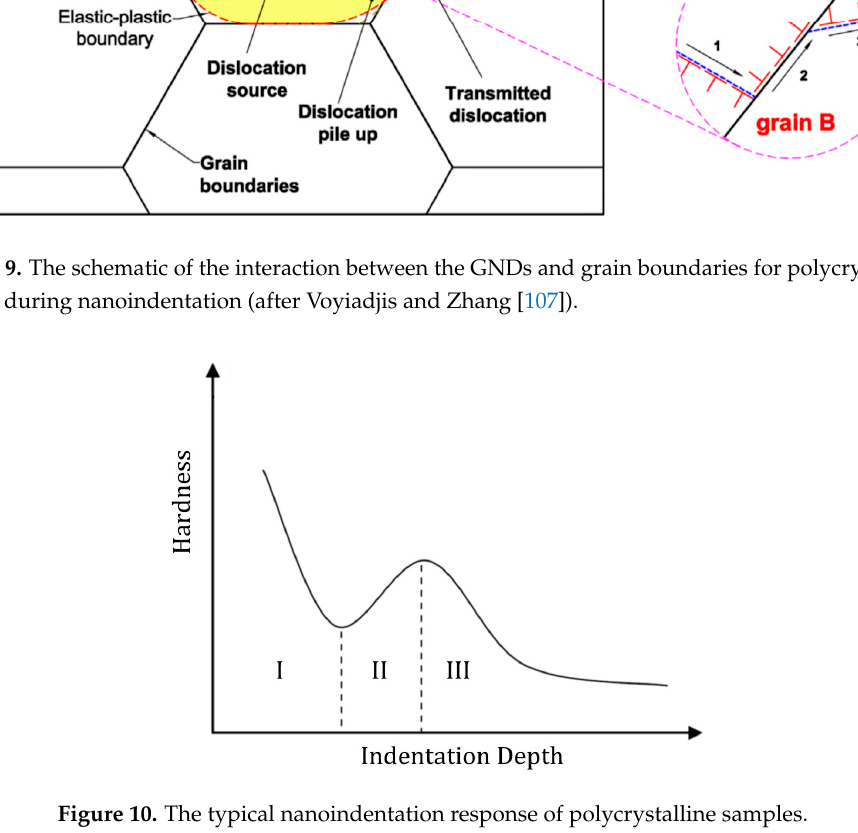
Figure 11. Effect of grain boundary on the nanoindentation response of crystalline metals: ( a ) distances between the grain boundary and indentations for Al bicrystal sample; ( b ) the effect of the distance from indentation to the grain boundary on the nanoindentation response of the Al bicrystal sample; ( c ) distances between the grain boundary and indentations for the Cu bicrystal sample; ( d ) the effect of the distance from indentation to the grain boundary on the nanoindentation response of the Cu bicrystal sample (after Voyiadjis and Zhang [107] and Zhang and Voyiadjis [108]). 4. Recent Experimental Observations and Theoretical Models The fundamental assumption in the size effects model based on the density of GNDs following the Nix and Gao model [13] is that the forest hardening is the governing mechanism. Accordingly, they relate the size effect to the GNDs induced by the strain gradient, which enhances the nanoindentation response. As described by Swadener et al. [14], Feng and Nix [98] and Huang et al. [99], the Nix and Gao model [13] cannot capture the size effects at shallow indentation depths. Although different methods of modifying the plastic zone volume [98] and assigning a GND saturation cap [99] solved the model